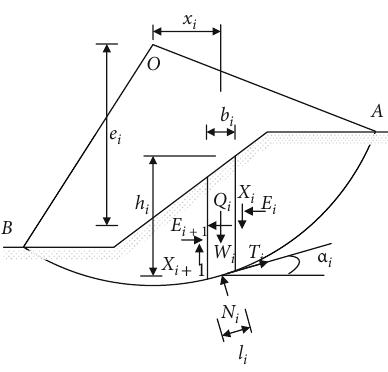
Figure 7: Schematics of Bishop ’ s method.